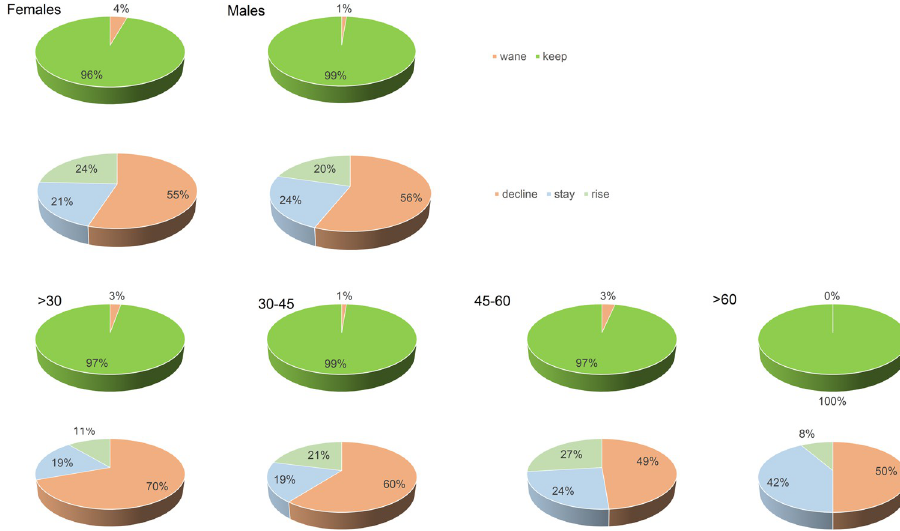
Fig 4. Sex and age relationship to outcomes of anti SARS-CoV-2 total antibodies. Proportion of donors keeping or waning total immunoglobulins recognizing anti SARS-CoV-2 N protein and donors whose total immunoglobulins recognizing anti SARS-CoV-2 N protein will decline, remain the same or rise, layered by sex and by age group. Wane: Positive donor becomes negative; decline: OD under 90% of the previous one; stay: OD +/-10% of the previous one; rise: OD over 110% of the previous one.